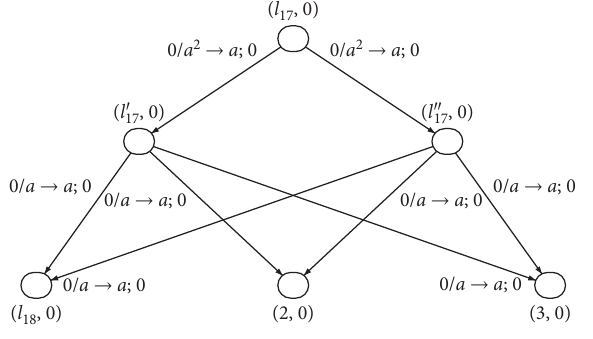
Figure 10: ADD-ADD module of Π